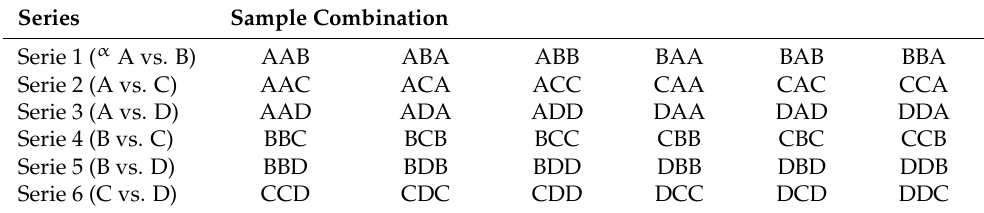
Table 1. Combinations of the different